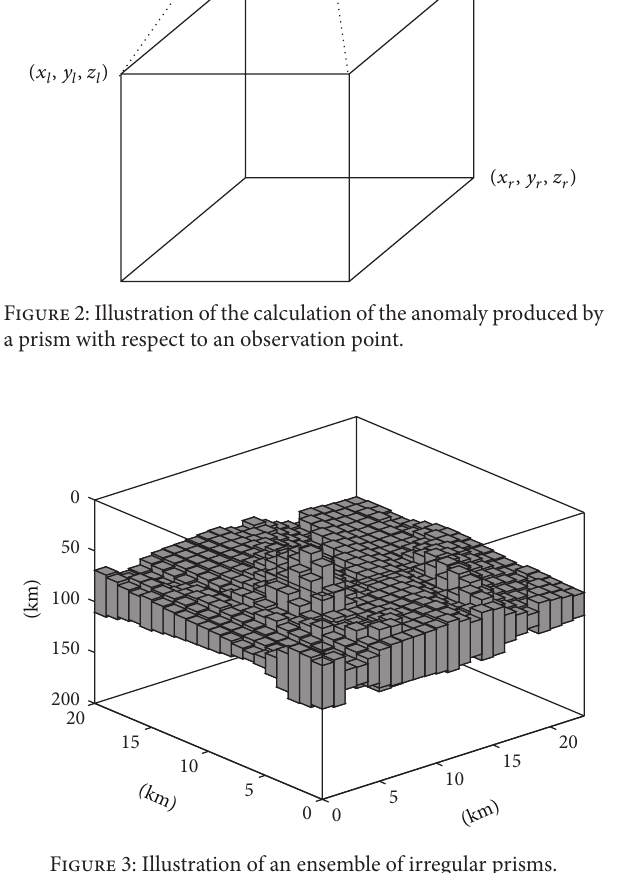
Figure 3: Illustration of an ensemble of irregular